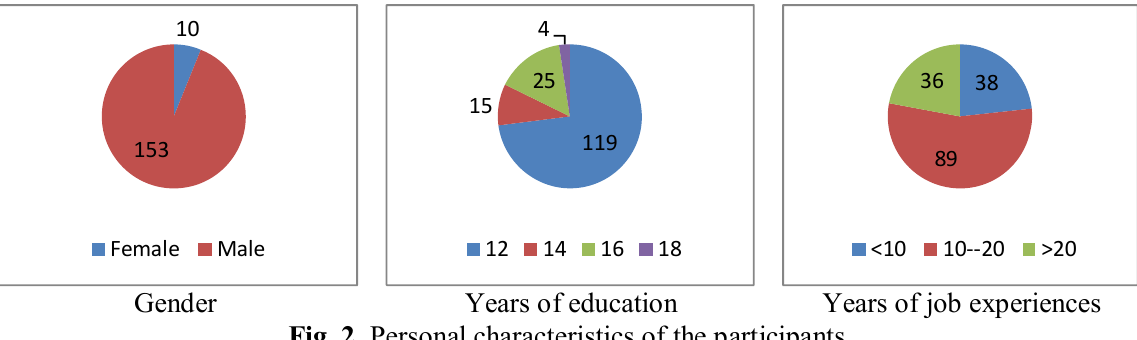
Fig. 2. Personal characteristics of the participants